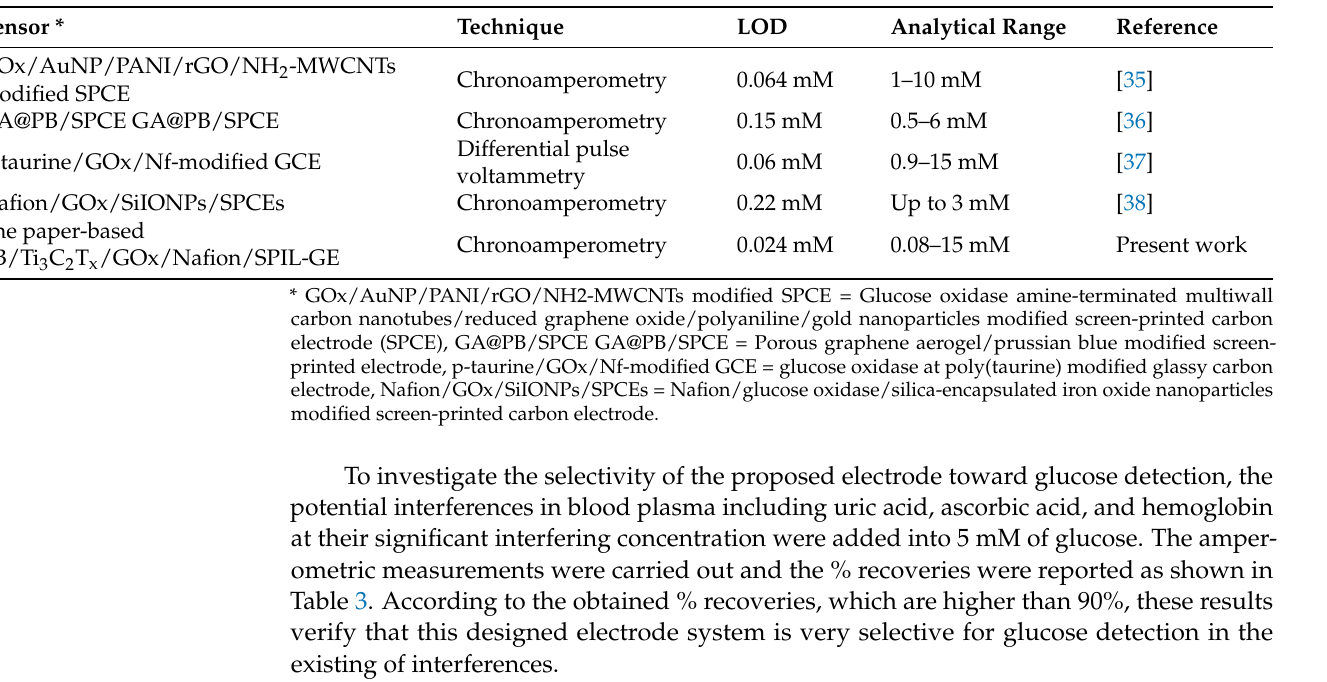
Table 2. Comparative performance of this as-prepared sensor and some others for the determination of glucose.